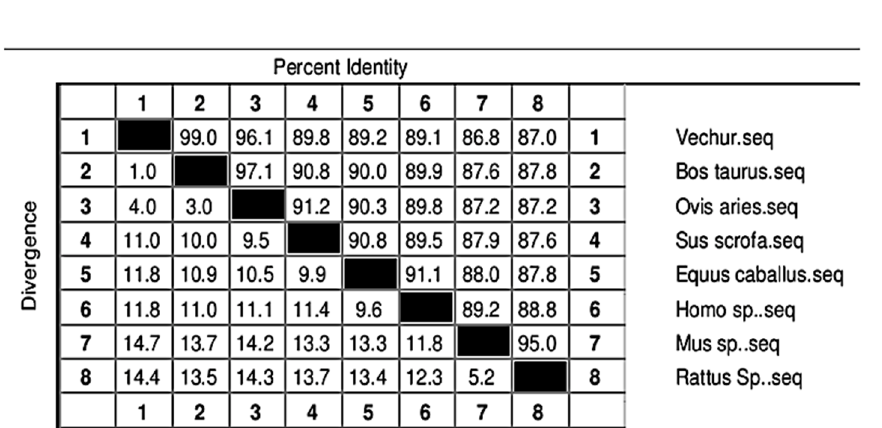
Figure 3. Relative expression of the ATP1A1 gene in Vechur, Kasaragod, and crossbred cattle during